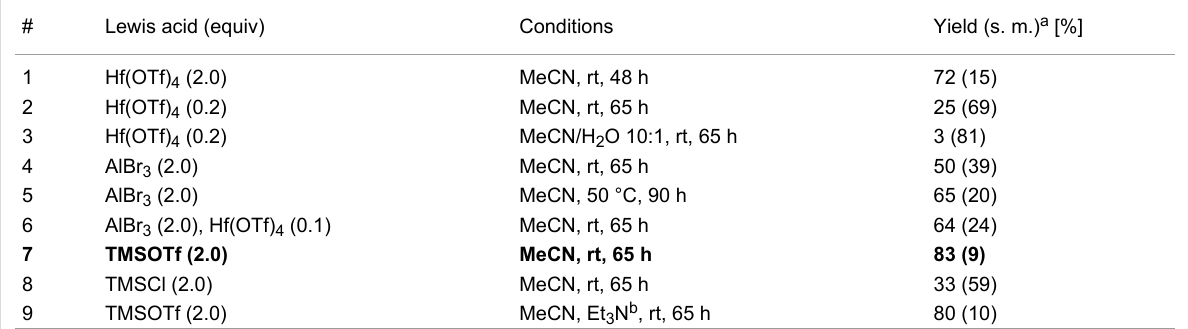
Table 1: Selection of optimization experiments.